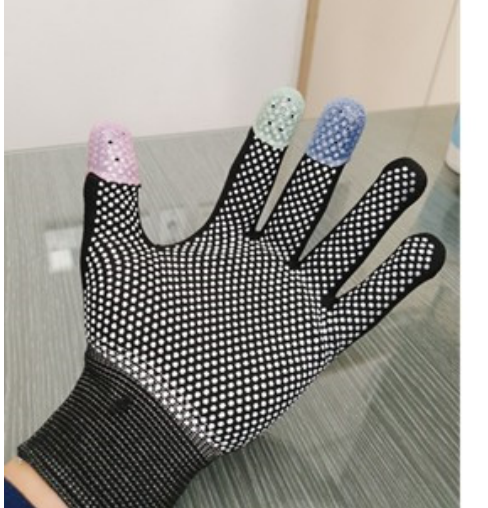
Figure 9. Wearable system for gesture recognition.